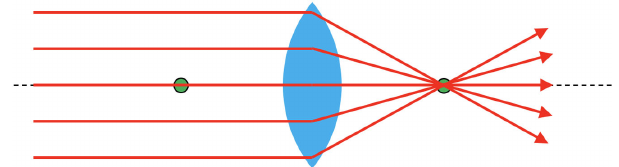
FIG. 2. Diagram of light particles passing through a converging lens. This is similar to the diagram Mr. Buford drew on the whiteboard during his explanation of the activity. Students learned about how light travels through a converging lens during a previous class